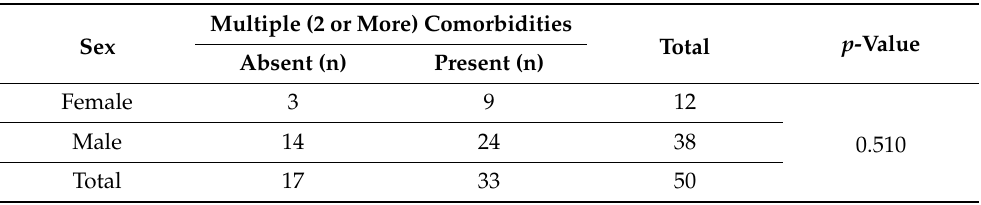
Table 2. Sex wise distribution of multiple comorbidities among mortalities in STIDH (n = 50).